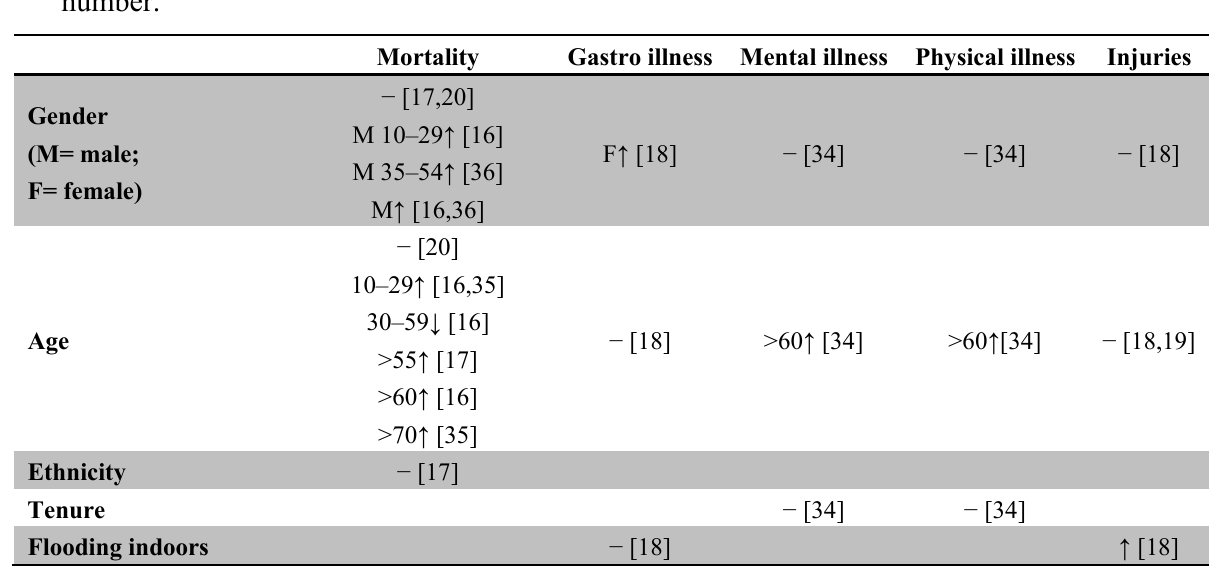
Table A5. During-flood risk factors identified from studies that examined risk factors for those flooded in terms of health effects ( i.e. , answered research questions 1 and 3a). N.B. ↑ = risk factor; ↓ = protective factor; − = not significant; [x] indicates study reference